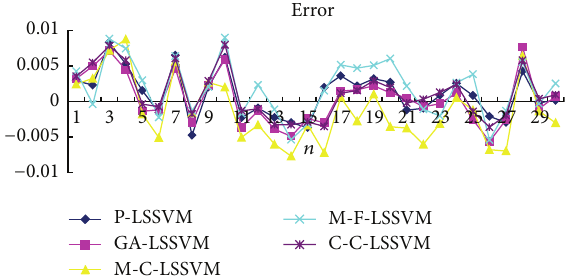
Figure 14: Five models predicted error diagram for interphone